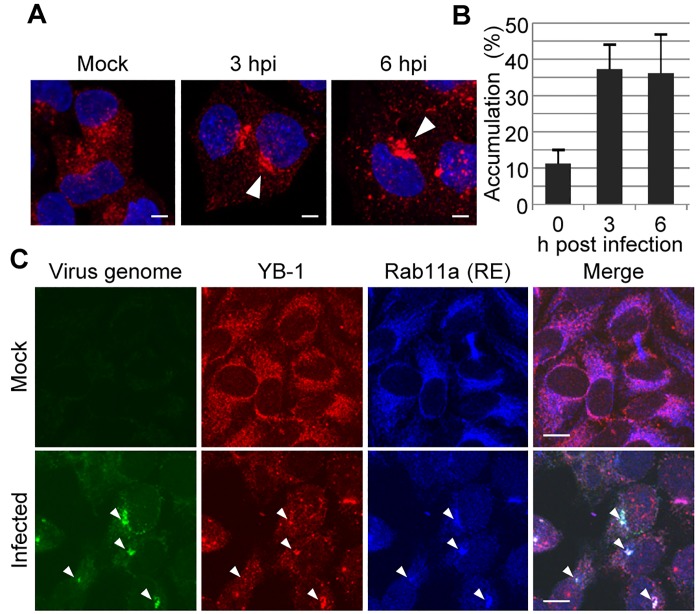
Formation of pericentrosomal ERC with the virus genome and YB-1 in infected cells.(A and B) Transferrin uptake. HeLa cells were pulse-labeled with 100 μg/ml of transferrin conjugated with Alexa 568 (red; arrowhead) for 30 min at 37°C at 0, 3, and 6 h post infection, respectively. After washing with medium, cells were further incubated for 30 min at 37°C. Nuclei were counter-stained with DAPI (blue). The average number of cells showing accumulation of transferrin larger than 1 μm was obtained from three independent experiments (panel B; n = 100). (C) Intracellular localization of the virus genome, YB-1, and Rab11a. At 6 h post infection, uninfected (upper panels) and infected HeLa cells (lower panels) were subjected to indirect immunofluorescence assays with anti-YB-1 (red) and anti-Rab11a (blue) antibodies, followed by FISH assays using an RNA probe complementary to the virus genome (green). The representative results from three independent experiments are shown. Scale bar, 10 μm.